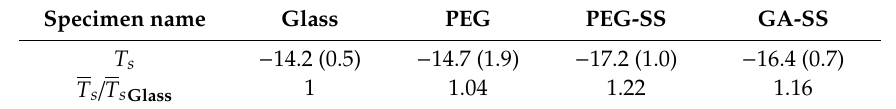
Table 2. Supercooling temperatures T s [ ◦ C] and the ratio of the average supercooling temperatures [ − ].